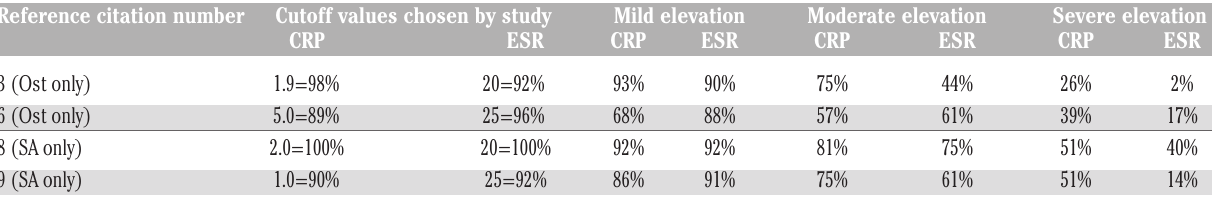
Table 3. Published C-reactive protein and erythrocyte sedimentation rate sensitivities for septic arthritis and osteomyelitis from differ- ent studies and recalculated C-reactive protein and erythrocyte sedimentation rate sensitivities. Reference citation number